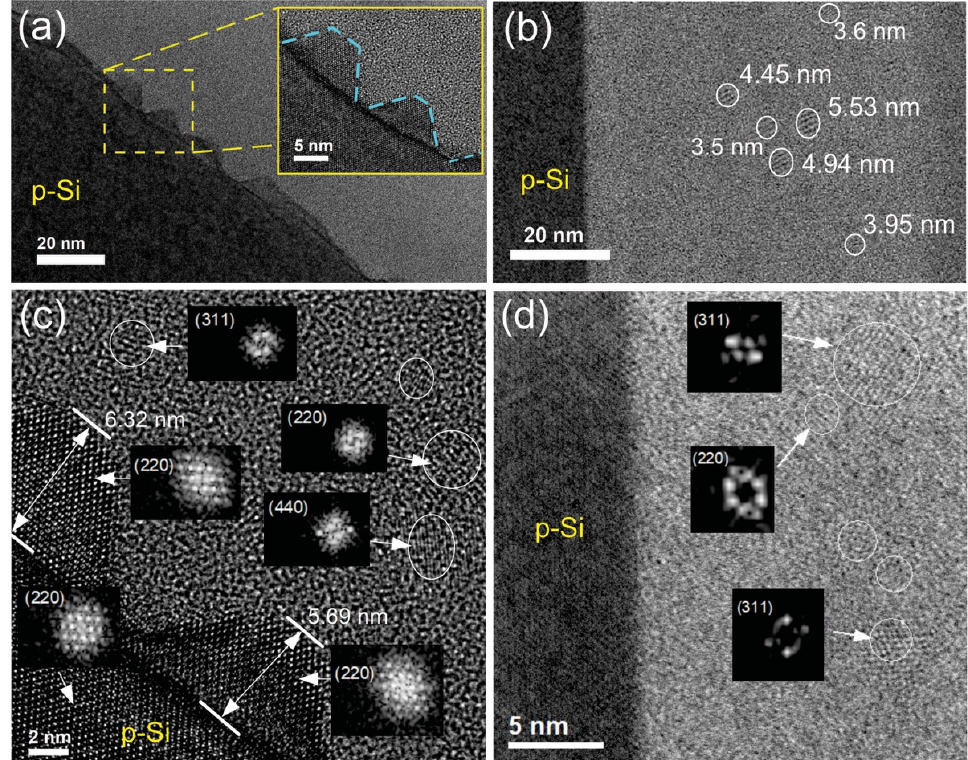
Figure 3. Cross-section HRTEM micrographs of the SRO/Si interface for ( a ) and ( c ) MLA and ( b ) and ( d ) MLB. Inset in ( a ) shows an enlarged image of the Si-nanopyramids.